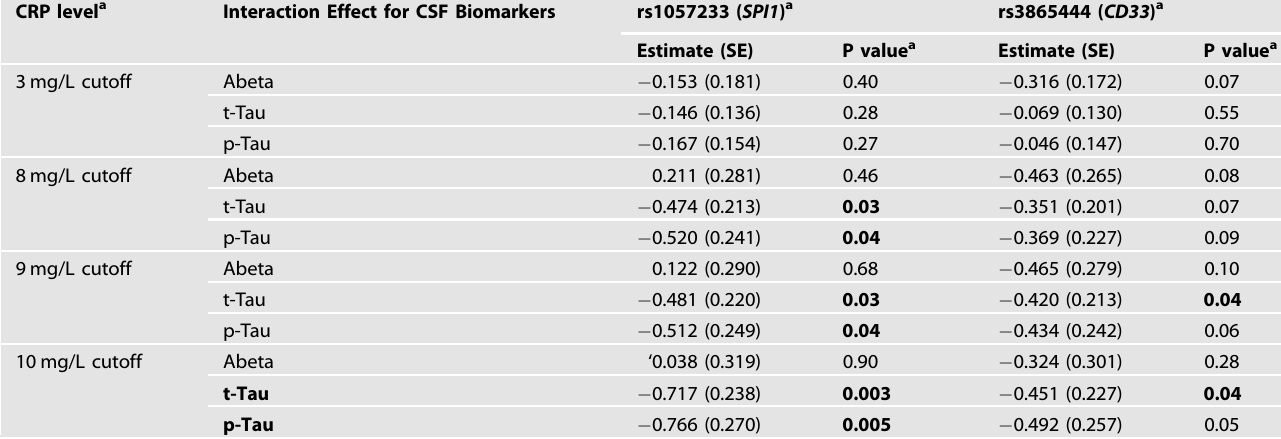
Table 3. Interaction between SNPs and high CRP on cerebral spinal fl uid ABeta42, t-Tau, p-Tau in the ADNI study. CRP level